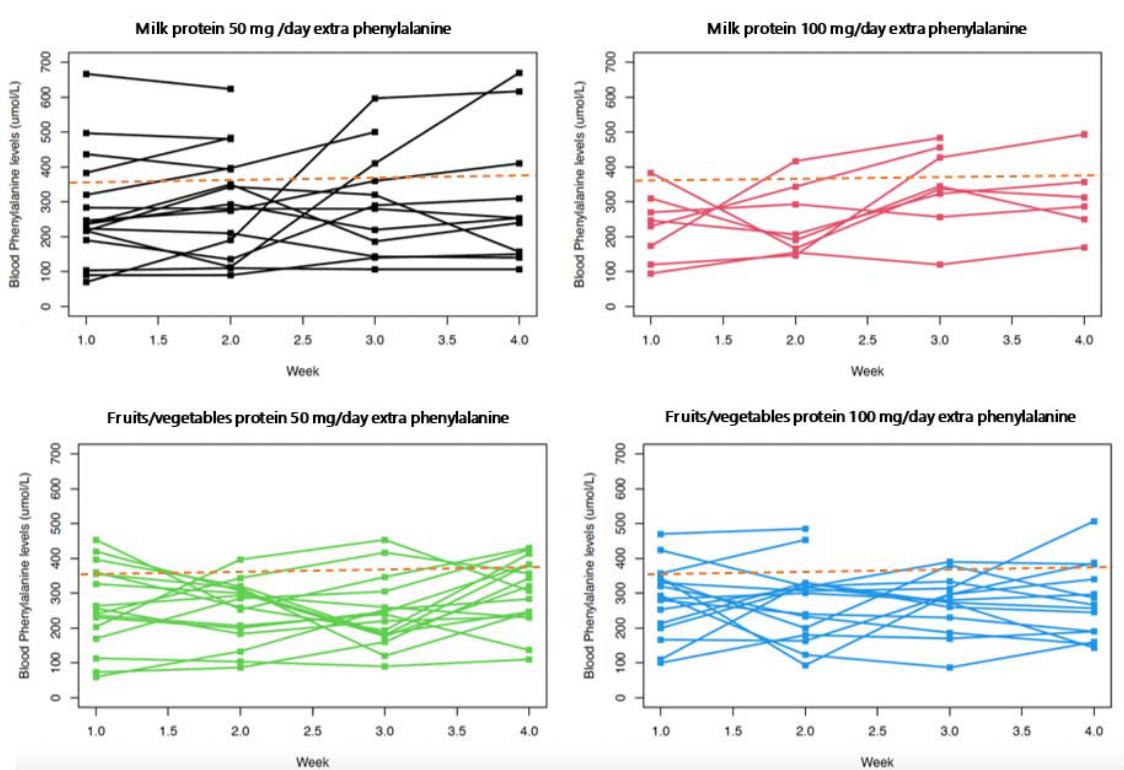
Figure 4. Individual blood phenylalanine levels over 4 weeks with each intervention. Dotted line shows recommended maximum blood phenylalanine concentration (360 μ mol/L). Black lines rep ‐ resent blood phenylalanine levels of all individual patients with 50 mg/day of extra phenylalanine from milk protein. Red lines show blood phenylalanine levels of all individual patients with 100 mg/day of extra phenylalanine from milk protein. Green lines represent blood phenylalanine levels of all individual patients with 50 mg/day of extra phenylalanine from fruit/vegetable protein. Blue lines show blood phenylalanine levels of all individual patients with 100 mg a day of extra phenyl ‐ alanine from fruit/vegetable protein.